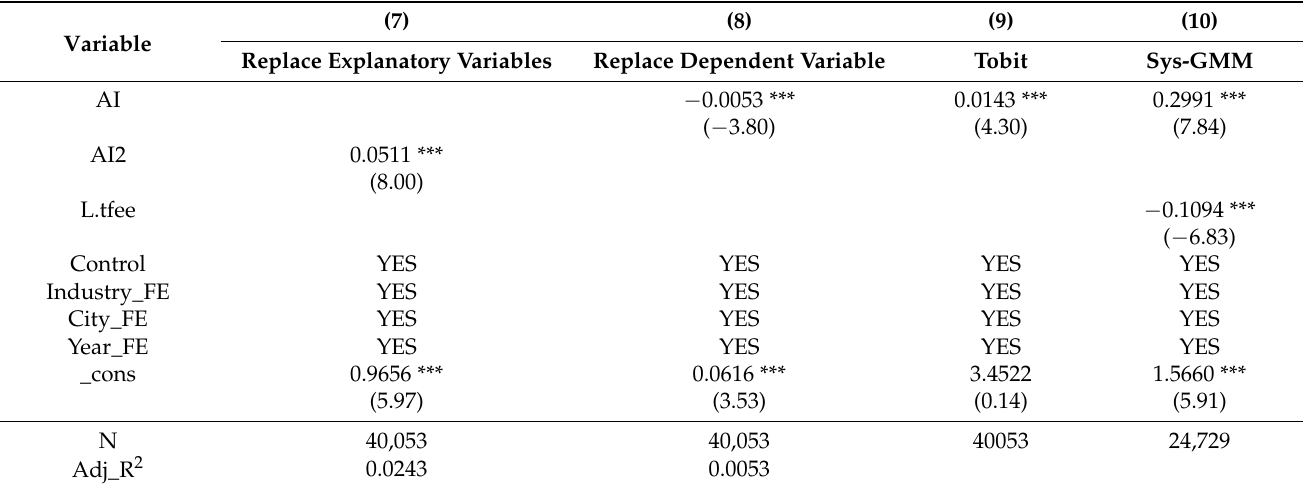
Table 5. Robustness